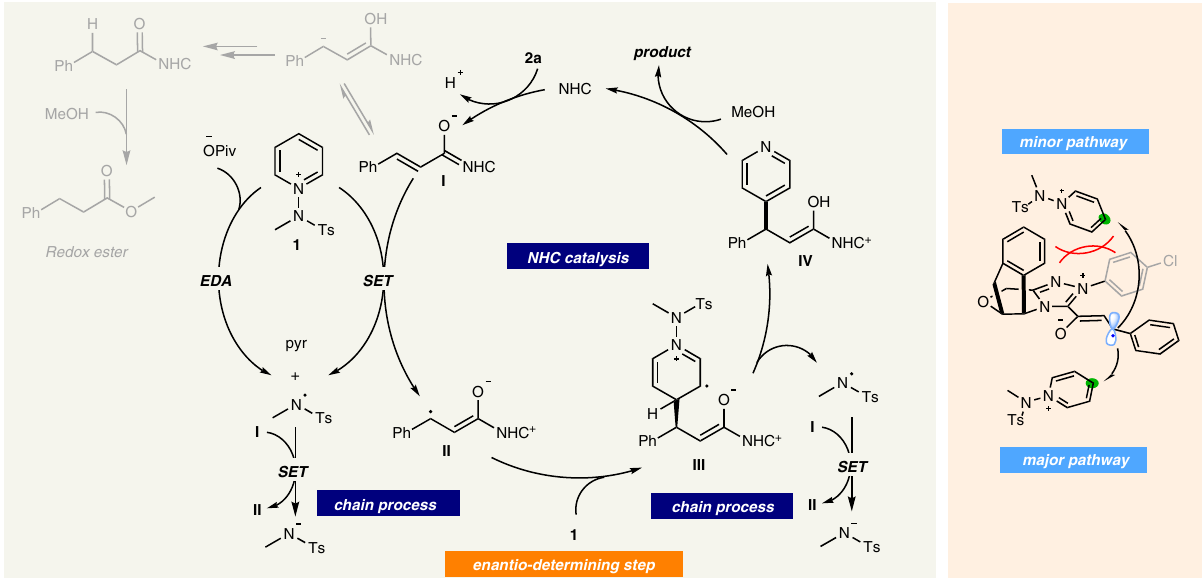
Fig. 5 Proposed reaction mechanism. The asymmetric β -pyridylation was achieved through single-electron NHC catalysis with excellent